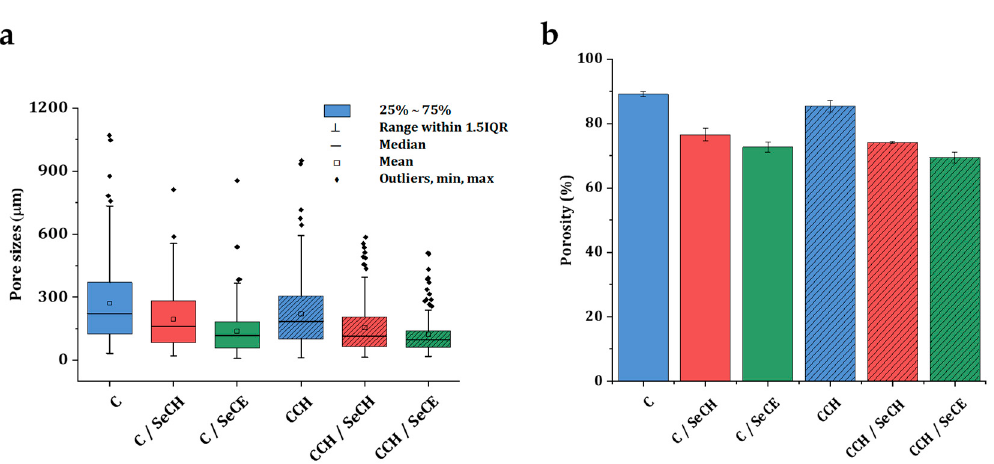
Figure 3. Box plot of C-based and CCH-based sca ff olds ( a ) representing a comparison of the pore size distribution, where the box represents the interquartile range (IQR) between 1st and 3rd quartiles. The lines represent the median, statistical minimum, and maximum represented by whiskers as a range within 1.5 IQR and the real minimum and maximum of the dataset included in outliers. Column plot of all types of C-based and CCH-based sca ff olds ( b ) representing the percentage porosity of the collagen-based sca ff olds enriched with two types of SeNPs.